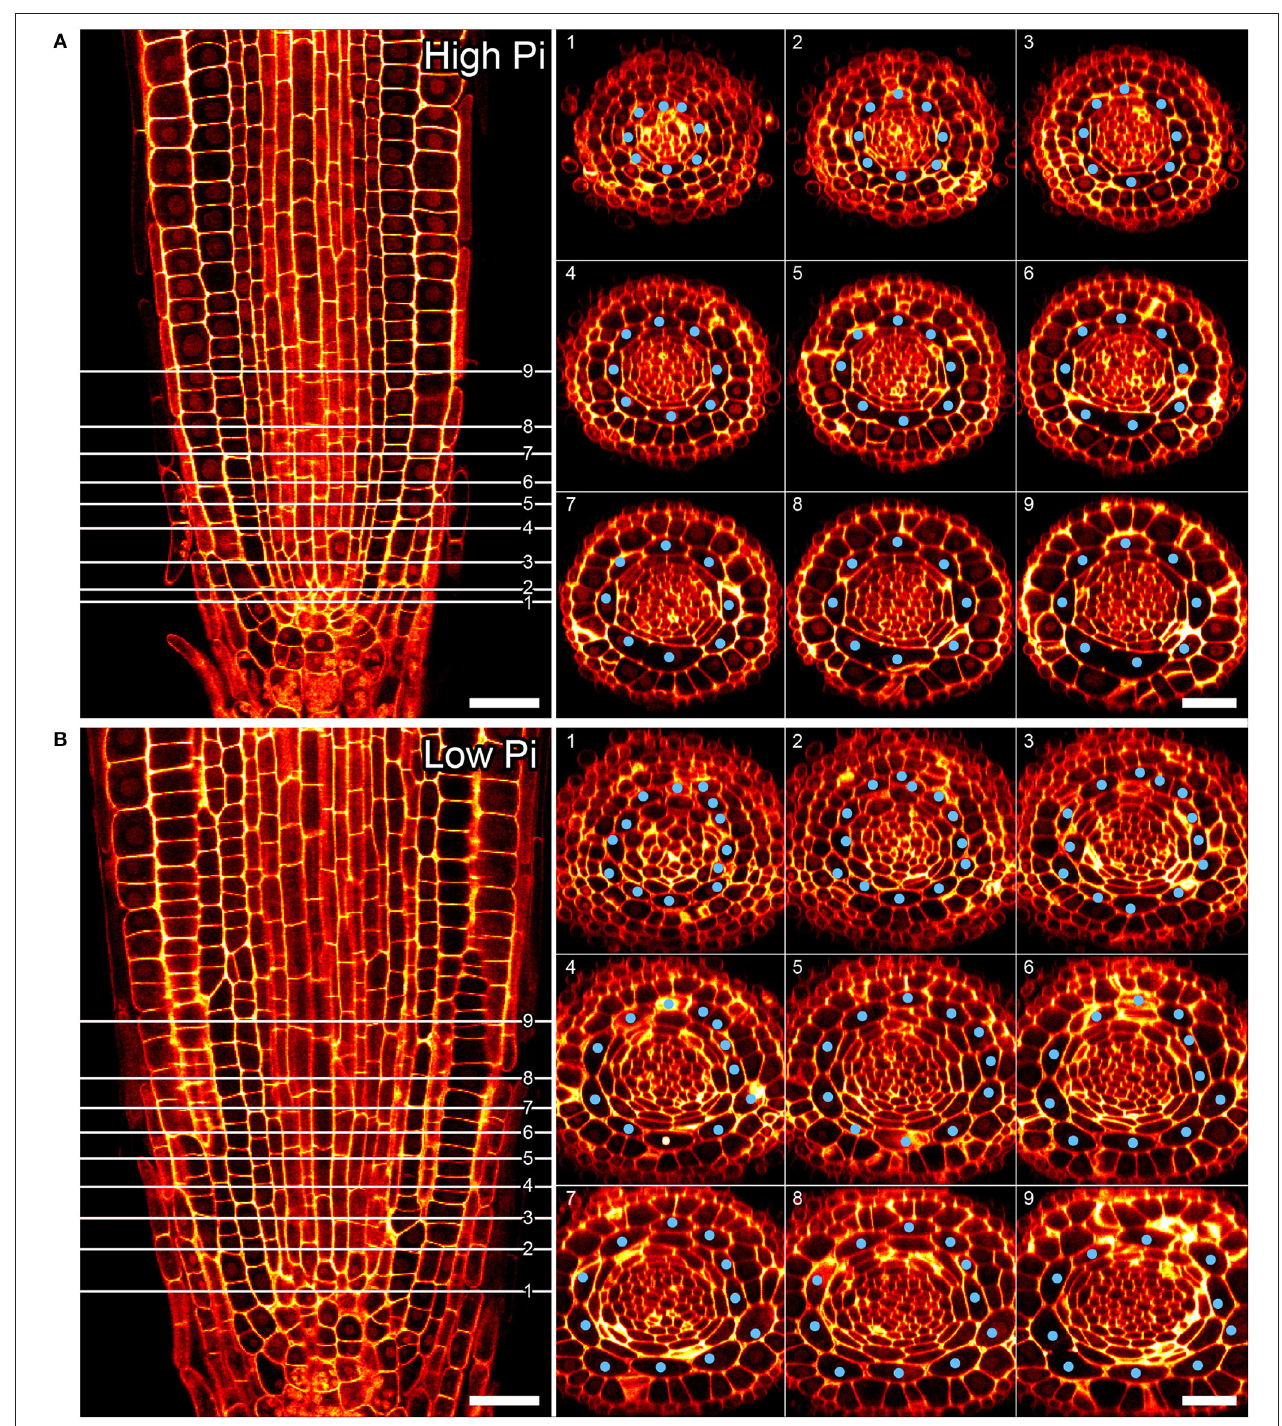
FIGURE 4 | Cortical cell proliferation occurs close to the root apical meristem. Reconstructed confocal Z-stacks of imaged pseudo-Schiff propidium iodide stained roots show that cortex cell file (blue spots) numbers are highest in proximity to the growing tip/cortex endodermis initial (CEI) cells in roots grown on 50 µ M phosphate (B) . Plant roots grown on 1mM phosphate containing medium exhibit 8 cortex cell files from 1 to 10 cell tiers (white lines) behind the cortex endodermal initial cell (A) . Cell file counts high P: n = 17; low Pi n = 30, differences between low and high Pi statistically significant p ≤ 0.001. Scale bar = 25 µ m.